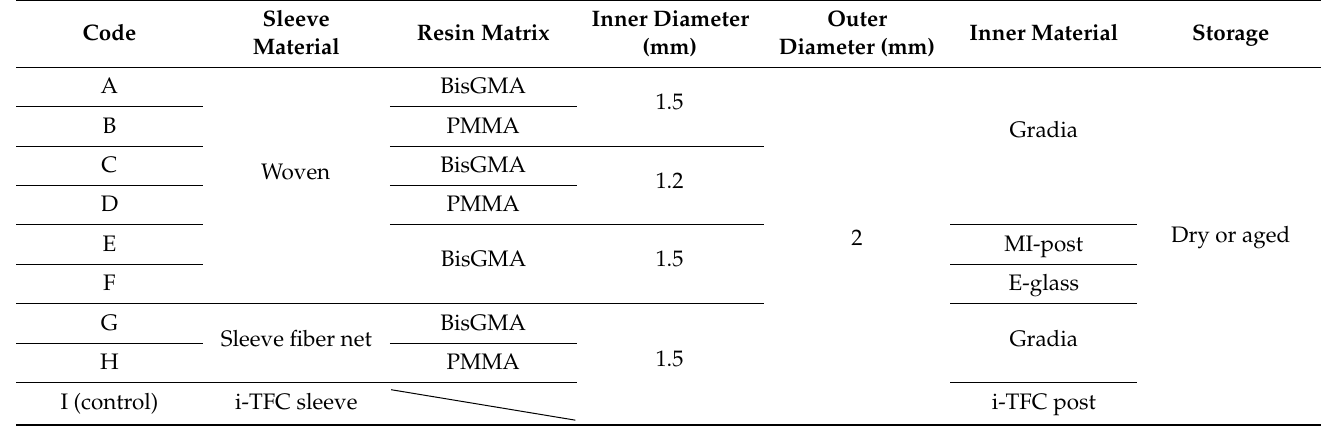
Table 2. Designed groups for the three-point bending test (n =